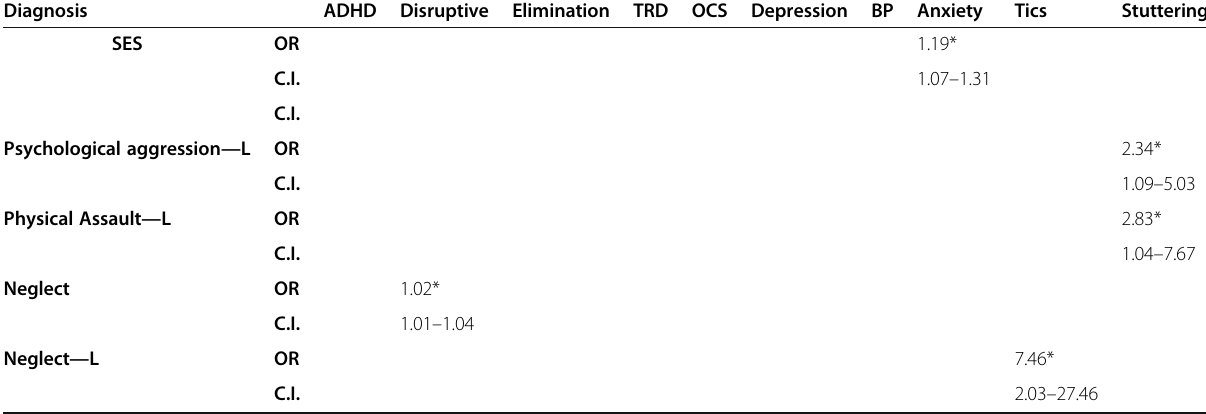
Table 3 Logistic regression for predictor variables significantly affecting psychiatric diagnostic categories